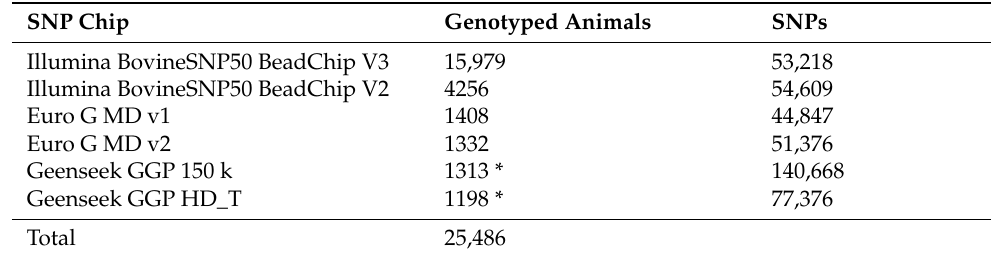
Table 1. The number of animals